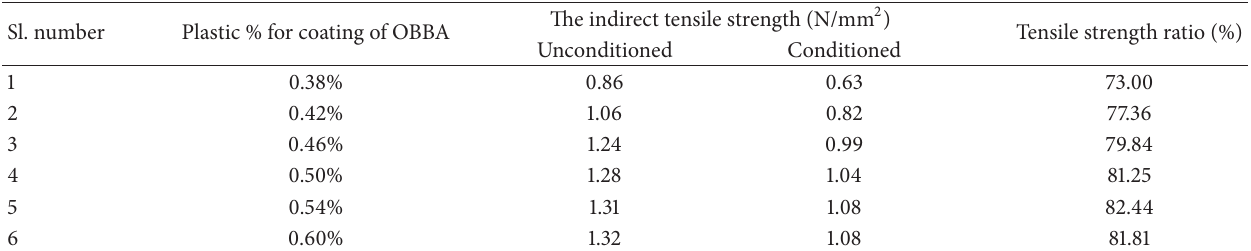
Table 9: Indirect tensile strength test